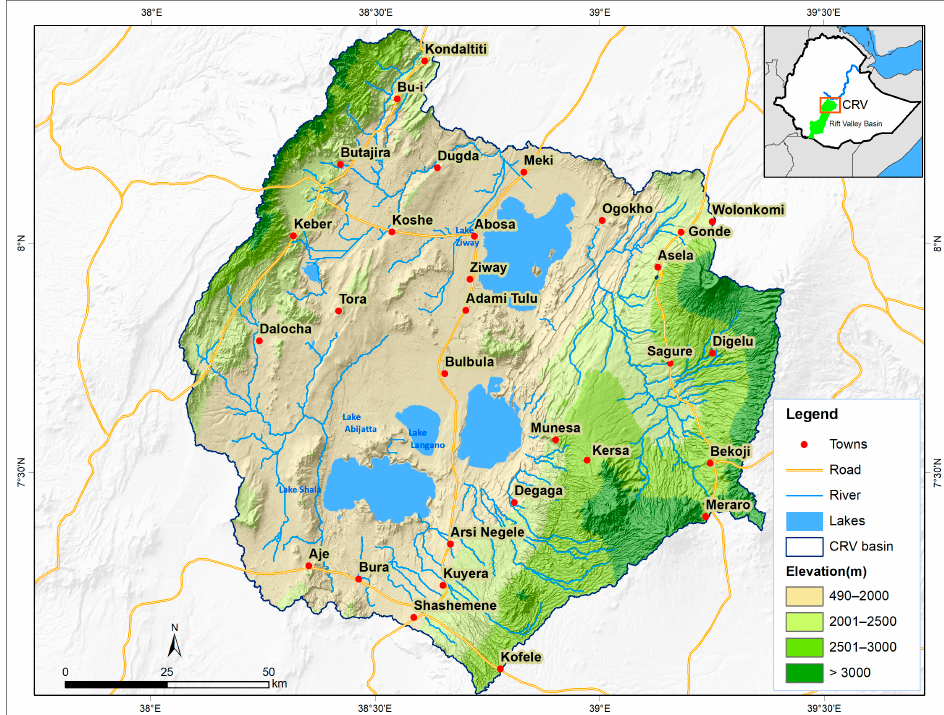
Figure 1. Location map of the Central Rift Valley sub-basin, Ethiopia.